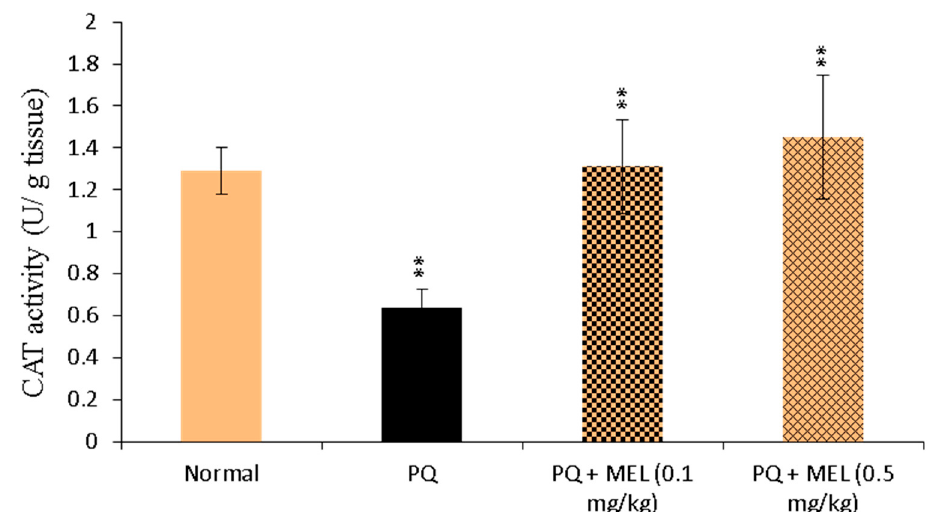
Figure 5. Effect of treatment with melittin (MEL) on catalase (CAT) activity in lung tissue homogenate. CAT was determined in the lung tissue homogenate through the Aebi method, using CAT colorimetric assay. The color intensity was measured, and CAT activity was determined and expressed as U/g tissue. Data are presented as mean ±SD. Results are significantly (** p < 0.01) different from the PQ group.